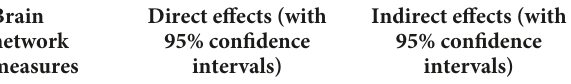
TABLE 2 Results of the mediation effect analyses on each brain network measures in the relationship between the short version of the smartphone addiction scale (SAS-SV) score and patient health questionnaire (PHQ-9)